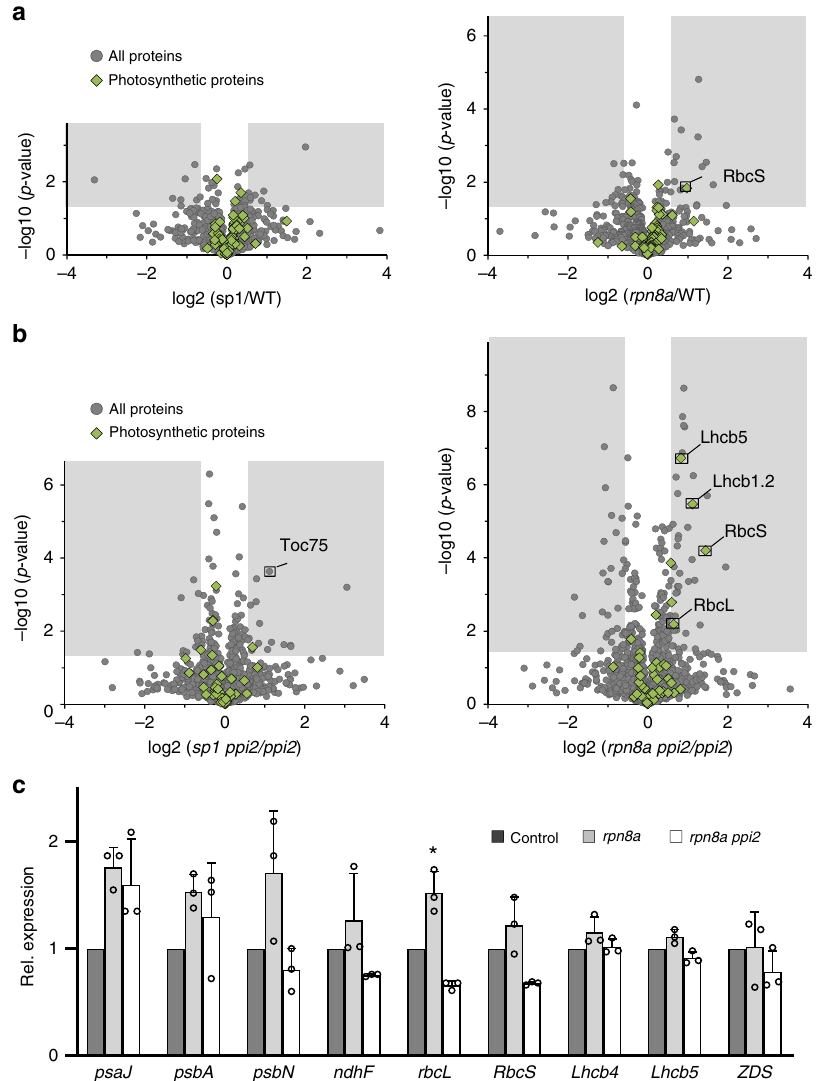
Fig. 5 Quantitative proteomics and real-time PCR analyses. a , b Volcano plot of the results from quantitative proteome pro fi ling with the different genotypic lines. Data on the x -axis represent the Log2-ratio between the absolute abundances of proteins identi fi ed from the sp1 (left plot) and rpn8a (right plot) single mutants against wildtype ( a ) and the Log2-ratio of absolute abundances between the sp1 ppi2 (left plot) and the rpn8a ppi2 double mutants against ppi2 ( b ). The y -axis represents the Log10 of the p -value from a two-sided T -test. Signi fi cant changes are indicated by the gray box (ratio > 1.5 times different, p -value < 0.05, T -test, two-sided). All data are based on three biological replicates that were measured in three technical replicates each. c Quantitative real-time PCR results obtained with the transcripts of selected genes for photosynthetic proteins. Signi fi cant differences from three biological replicates are highlighted by a star ( T -test, two-sided, p -value < 0.05), error-bars represent